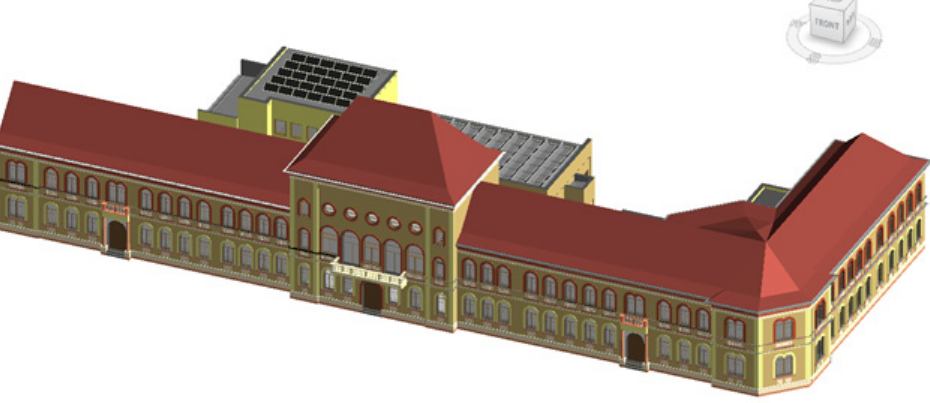
Figure 5. The BIM model of the building.